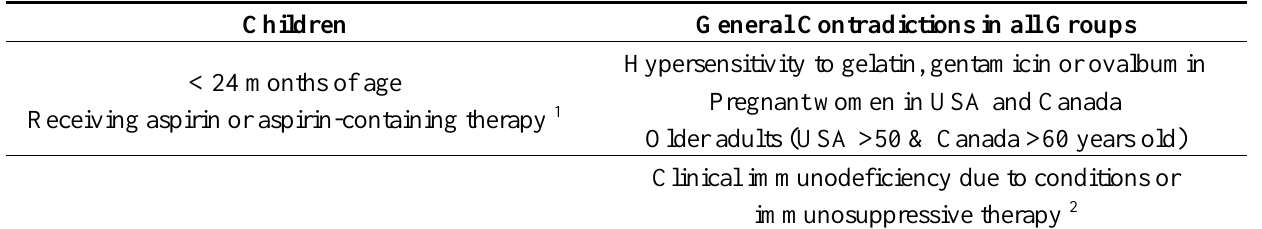
Table 2. LAIV is contraindicated in the following